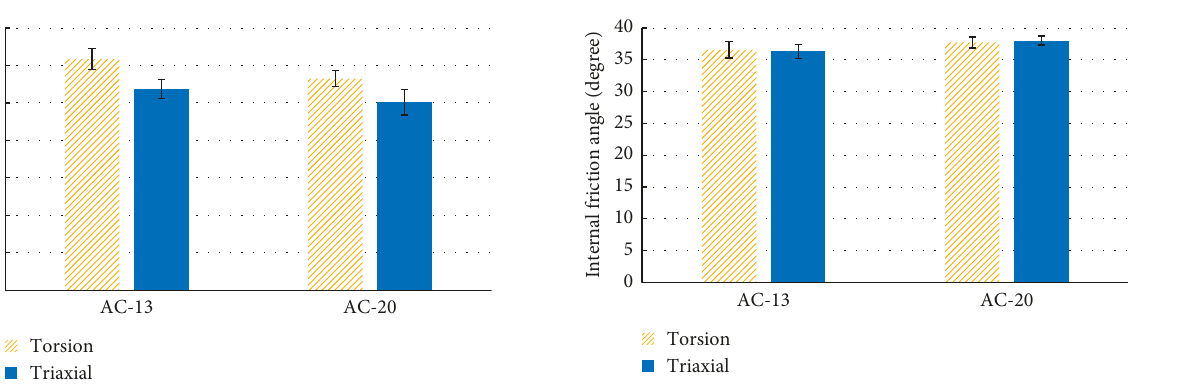
Figure 10: Results of cohesion C of different mixtures (60 ° C). Figure 11: Results of internal friction angle φ of different mixtures (60 °